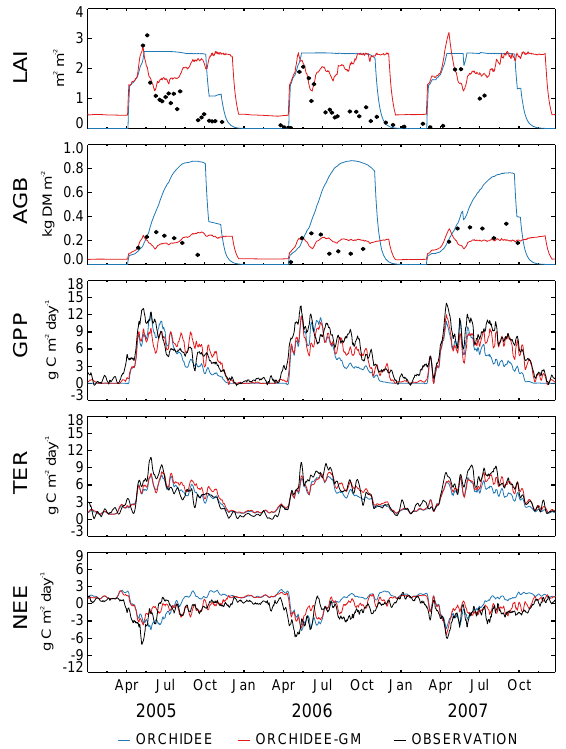
Fig. 5. Comparison of simulated/observed biometric variables and Figure 5 1032 carbon fluxes for the grazed grassland of Laqueuille, FR-Lq1. These large saw-teeth like fluctuations between two cuts are better reproduced by ORCHIDEE-GM than ORCHIDEE.